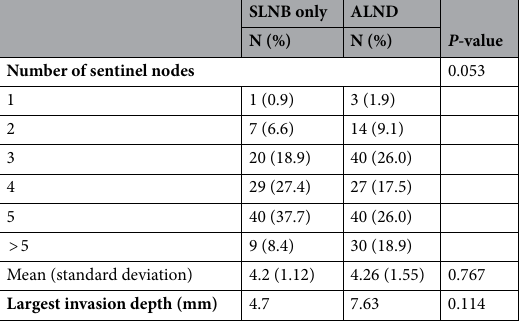
Table 2. Surgically removed axillary lymph node status. SLNB, sentinel lymph node biopsy; ALND, axillary lymph node